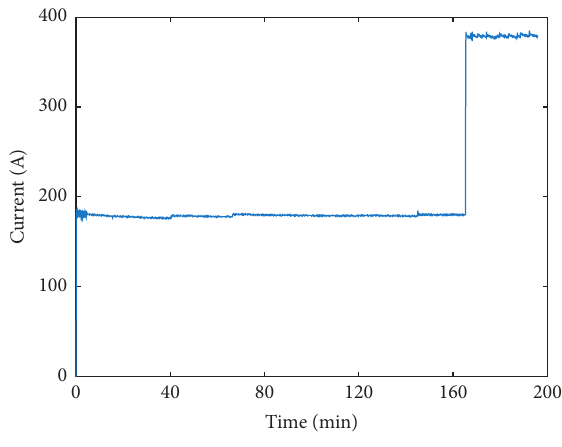
Figure 12: Cable current curve.